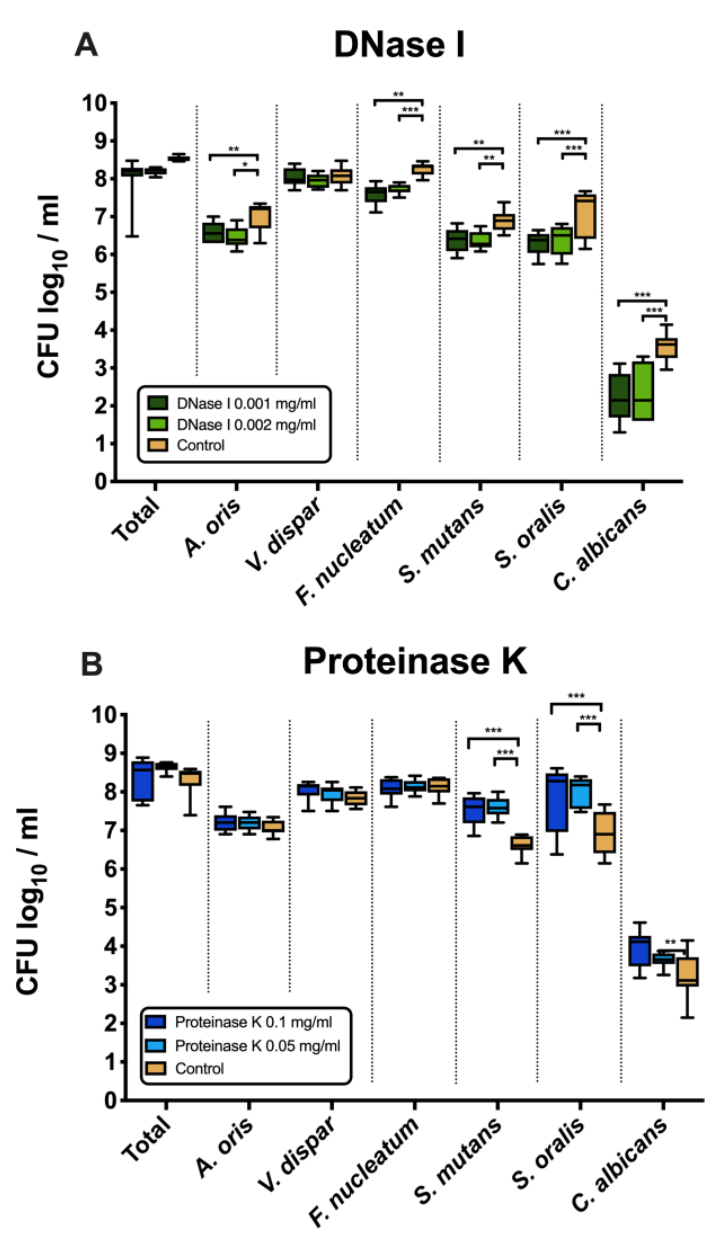
Figure 1. Box plots depicting the colony-forming units (CFUs) of six-species oral biofilms after exposure to DNase I (0.001 mg/mL, 0.002 mg/mL) ( A ) or proteinase K (0.05 mg/mL, 0.1 mg/mL) ( B ), respectively. Untreated biofilms were also tested as negative controls. The CFUs are shown on a log 10 scale per millilitre (Log 10 / mL ). Statistically significant differences are indicated with asterisks (* p < 0.030, ** p < 0.006, *** p < 0.0001).